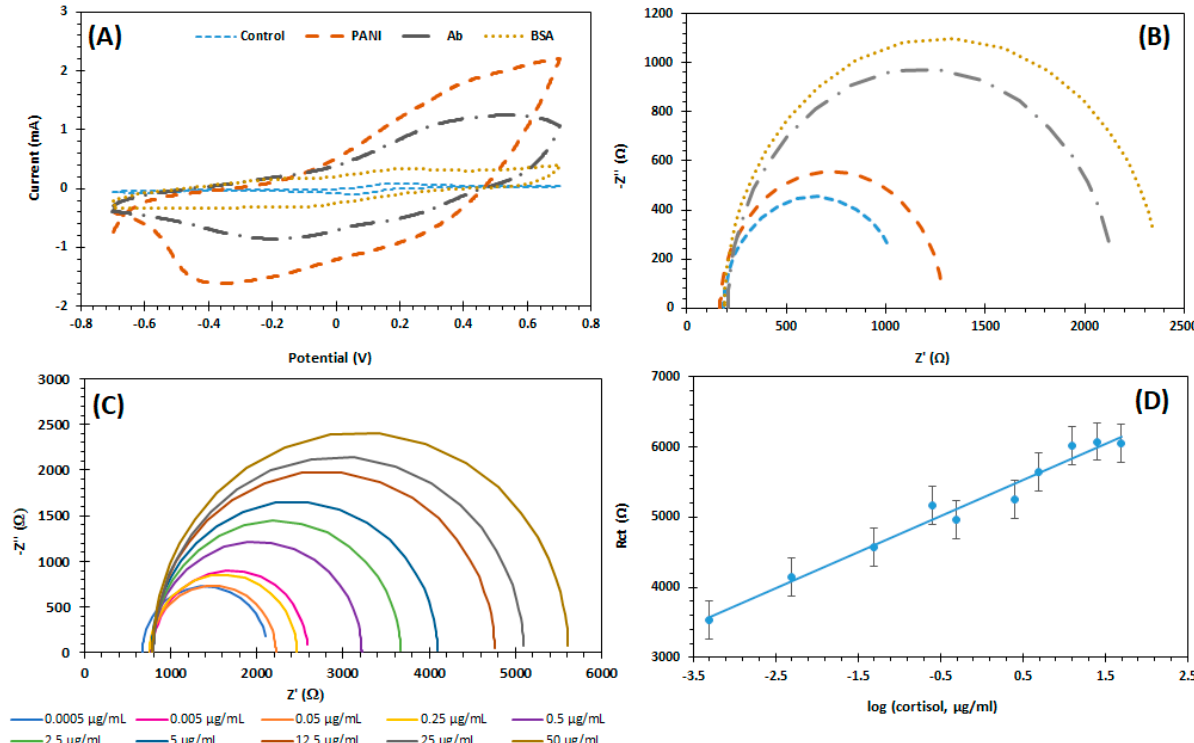
Figure 4. ( A ) CV of control, PANI, antibody and BSA; ( B ) Nyquist plots of control, PANI, anti-cortisol and BSA; ( C ) Nyquist plots for different concentrations of cortisol; ( D ) Calibration curve of R ct values for the different cortisol